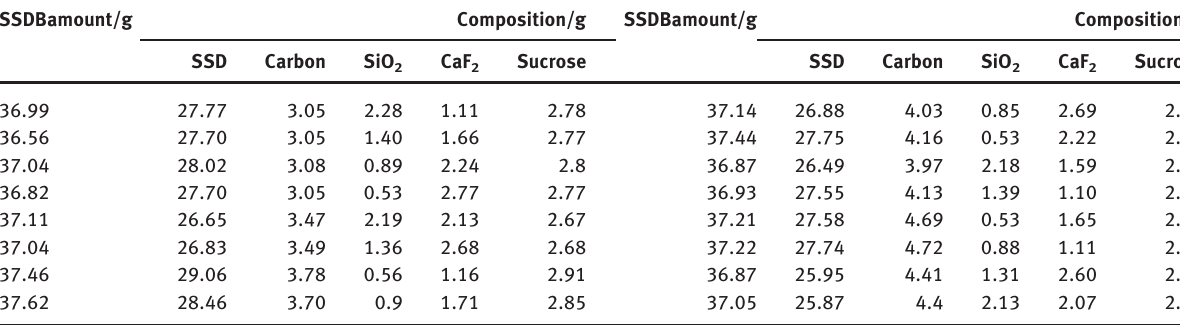
Table 1: Experimental parameters for briquette preparation.